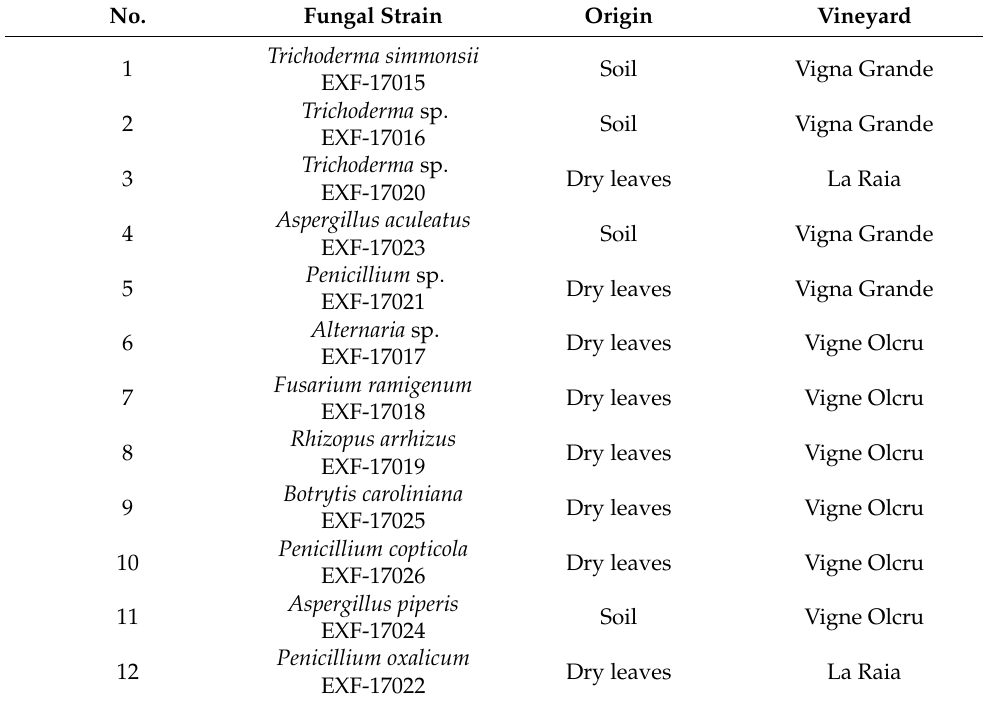
Table 2. Isolated plant-associated fungal strains with their EXF number (Ex Culture Collection) and in which vineyards are